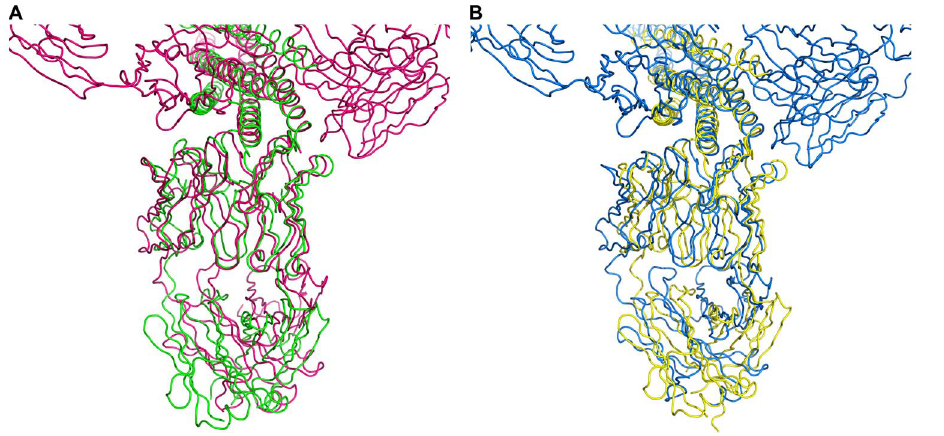
Figure 12. Superposition of the corresponding Fab 8066 and 8062 complexes with 3-H and 5-Helix based on the C a coordinates of three N-HR helices. (A) The (Fab 8066) 3 /3-H (red) and the Fab 8066/5-Helix (green) complexes. (B) The (Fab 8062) 3 /3-H (blue) and Fab 8062/5-Helix (yellow) complexes.